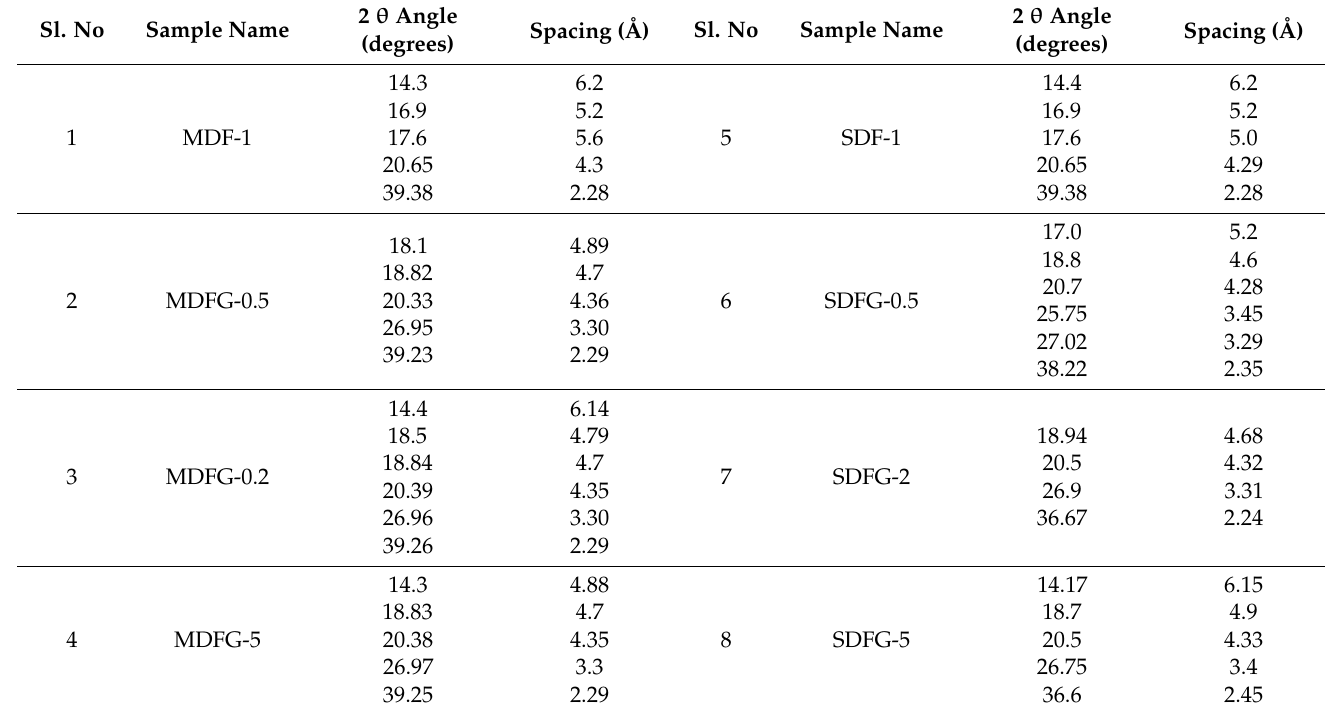
Table 5. d-Spacing Values of Nanocomposites Prepared by Different Methods.